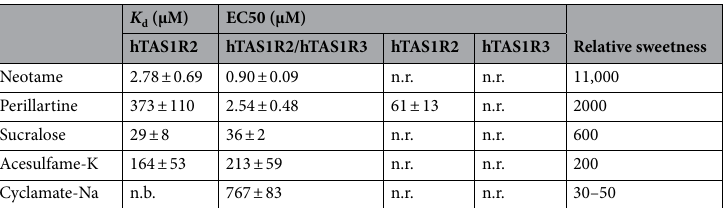
Table 1. Biochemical, biological and physiological features of sweet tasting compounds. K d values were determined by intrinsic tryptophan fluorescence. EC 50 values were calculated from the ligand dose–response relationship in HEK293T-Gα16gust44 cells transiently transfected with plasmid encoding pGP-CMV- GCaMP6S (fluorescent calcium biosensor), hTAS1R2-FLAG and/or hTAS1R3-FLAG. The relative sweetness of each sweetener is described on a molar basis. n.r. = no response; n.b. no